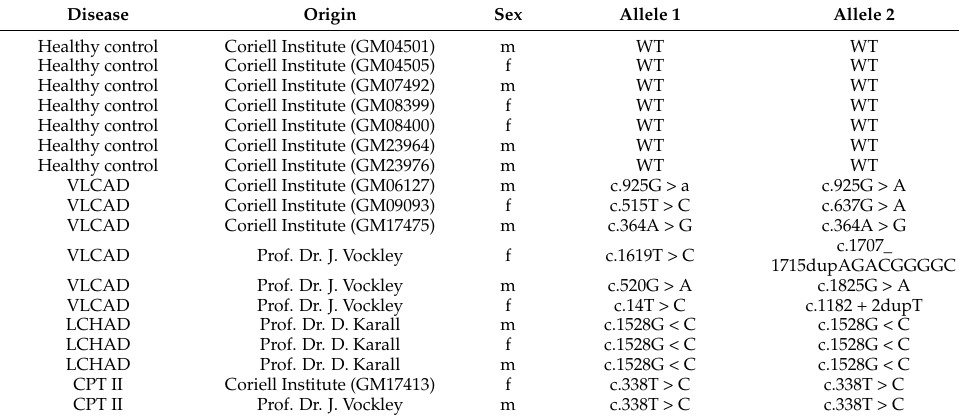
Table 1. Detailed information on the cell line used in this